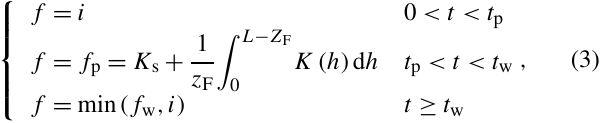
Figure 2. Details of the dynamic coupling of (a) the overland flow and sediment and pesticide transport through the VFS (contained in VFSMOD), with (b) the new infiltration and soil water redistribution with shallow water component (SWINGO). Colors indicate water (blue), sediment (brown), and pesticide (red) components. V , M , and m indicate water, sediment, and pesticide mass moving through the filter, where subscripts indicate incoming ( i ), outgoing ( o ), in sediment (sed), on the filter ( f ), infiltrated ( F ), in mixing layer (ml), and in runoff (ro). Other symbols are defined in the